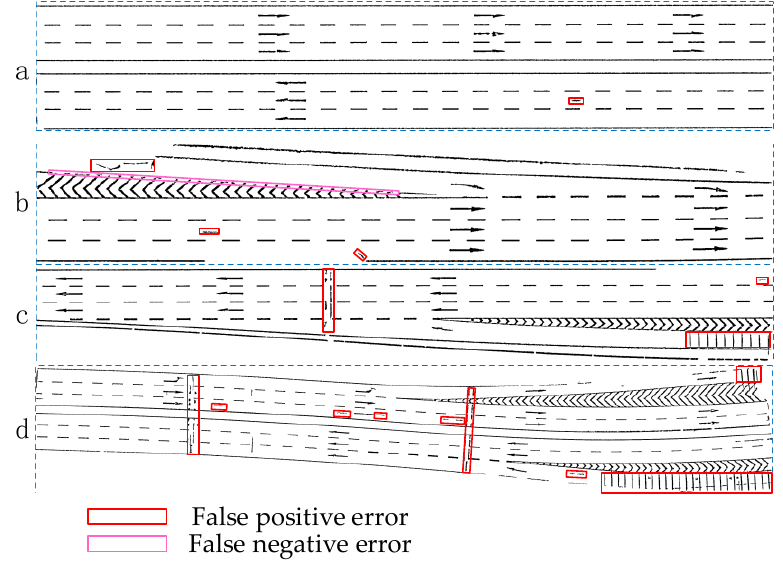
Figure 15. The result of the adaptive threshold segmentation. ( a ) Binary image converted from Figure 14a; ( b ) Raster image converted from Figure 14b; ( c ) Raster image converted from Figure 14c; ( d ) Raster image converted from Figure 14d.